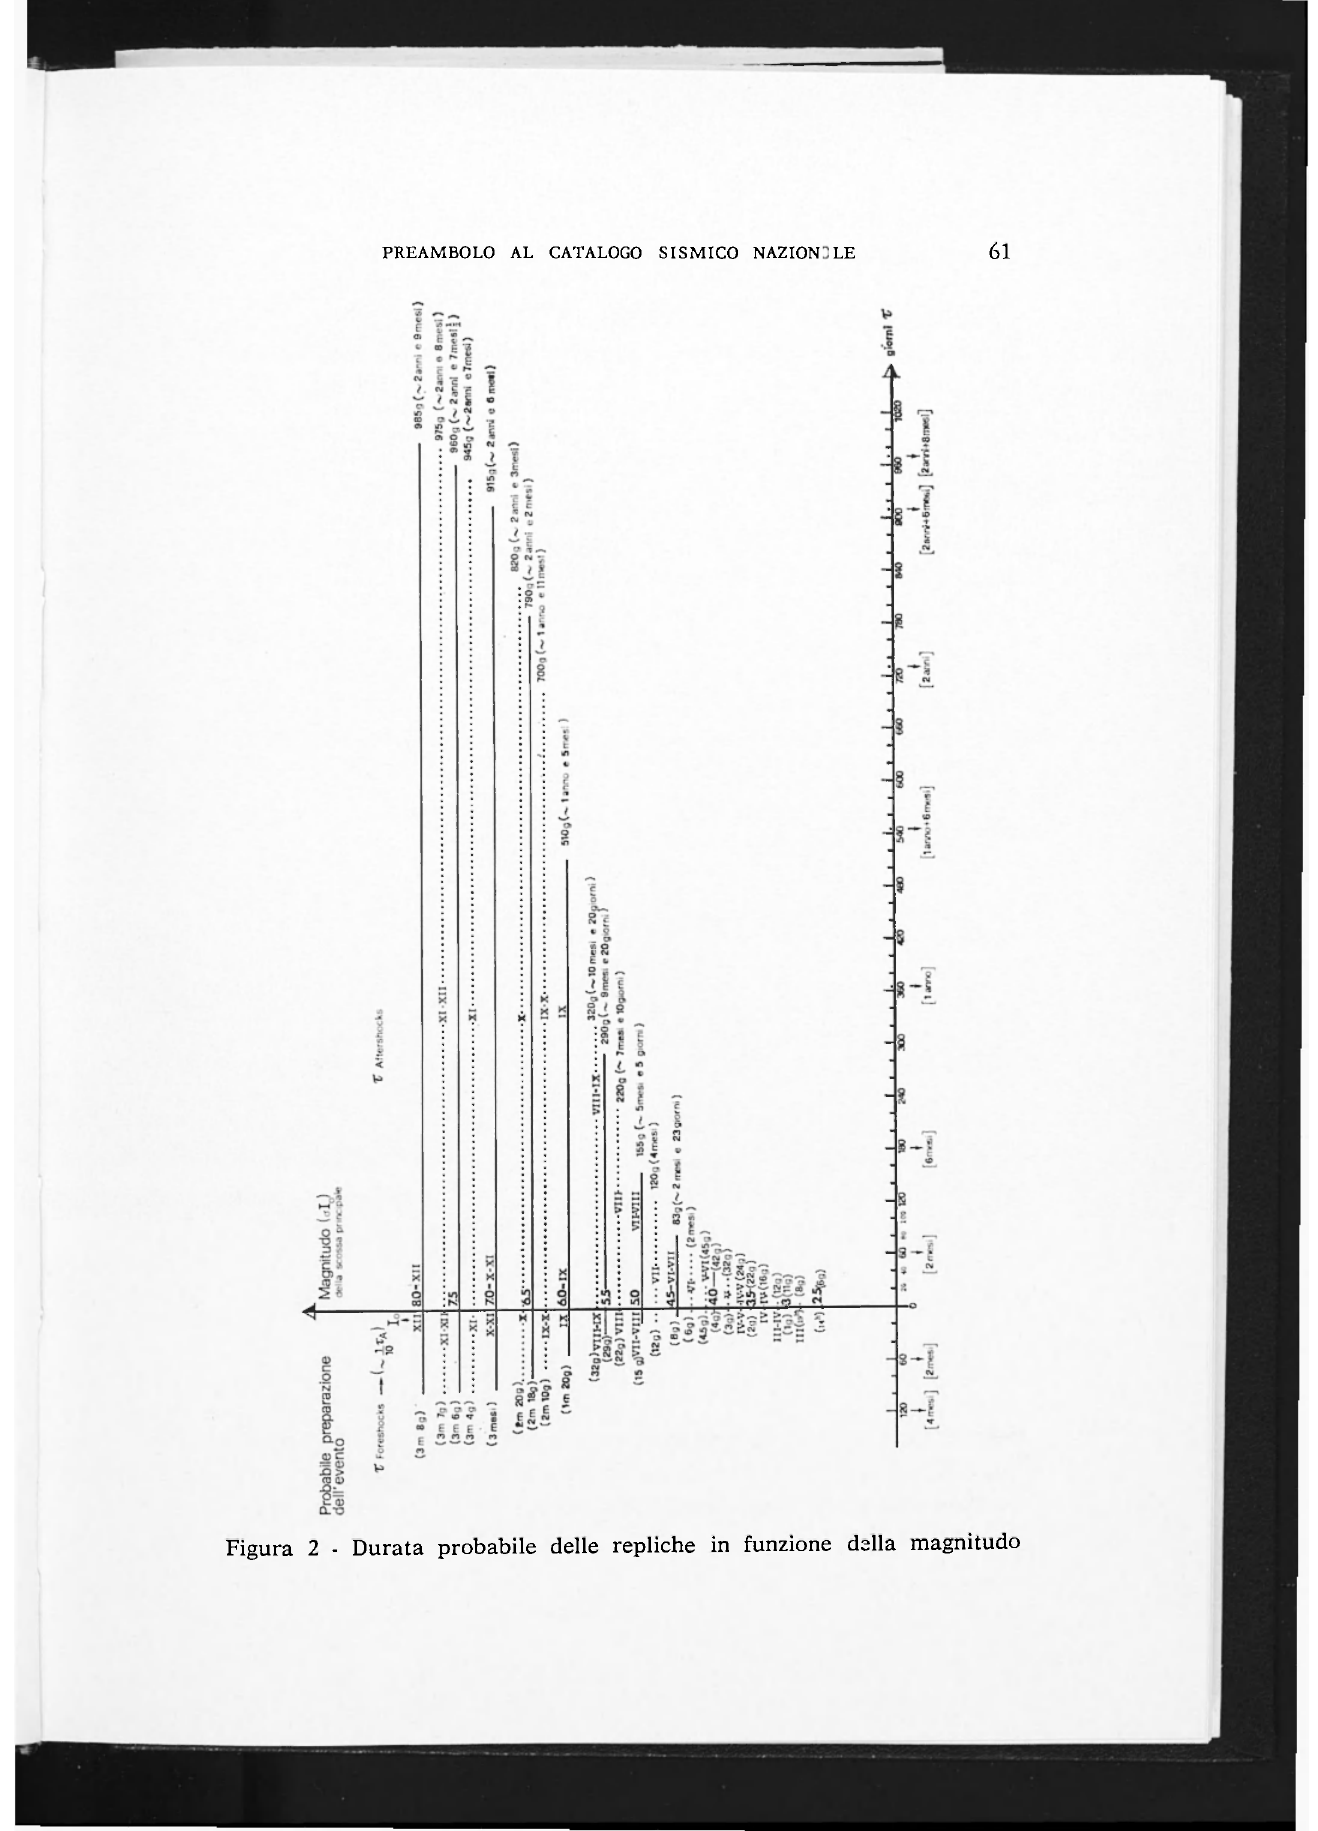
Figura 2 - Durata probabile delle repliche in funzione della